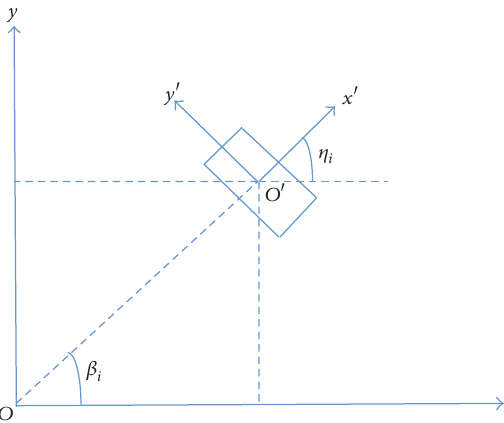
Figure 3: The structure of 𝑖 th omnidirectional wheel. Figure 4: All three coordinates in OMR system.